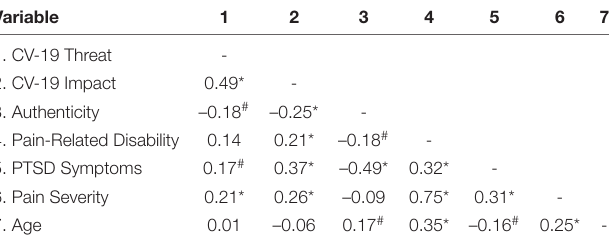
TABLE 5 | Correlations between variables of